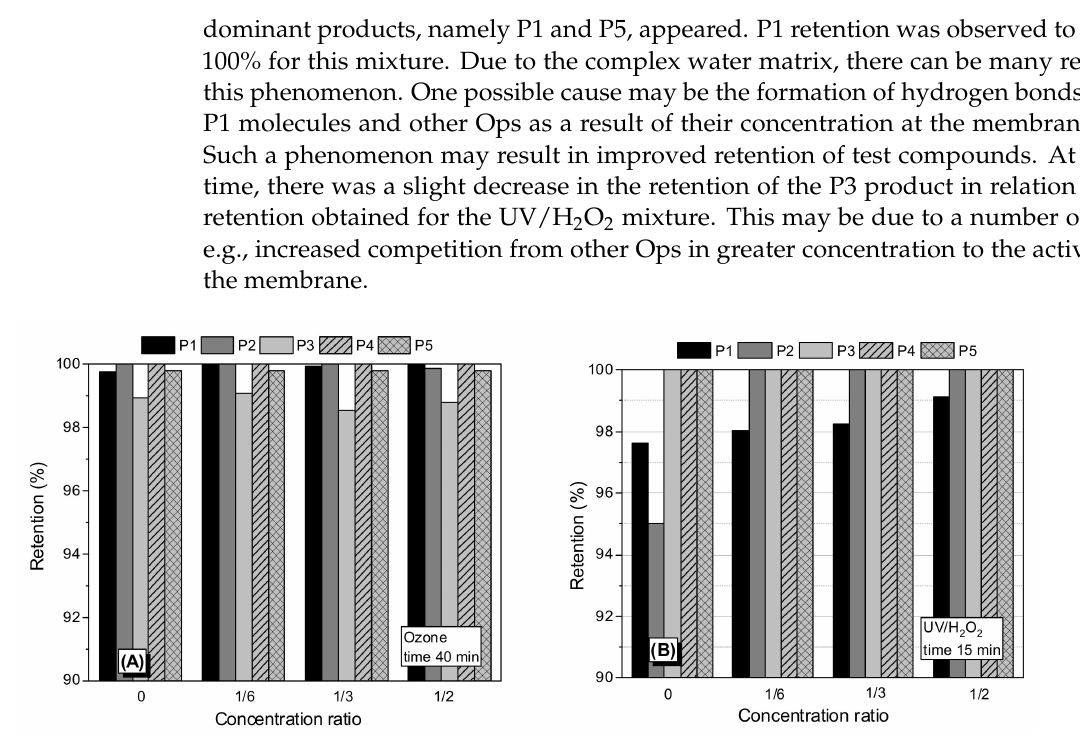
Figure 6. Ops retention ( A ) for 40 min of ozonation; ( B ) for 15 min of UV/H 2 O 2 oxidation; membrane HL.